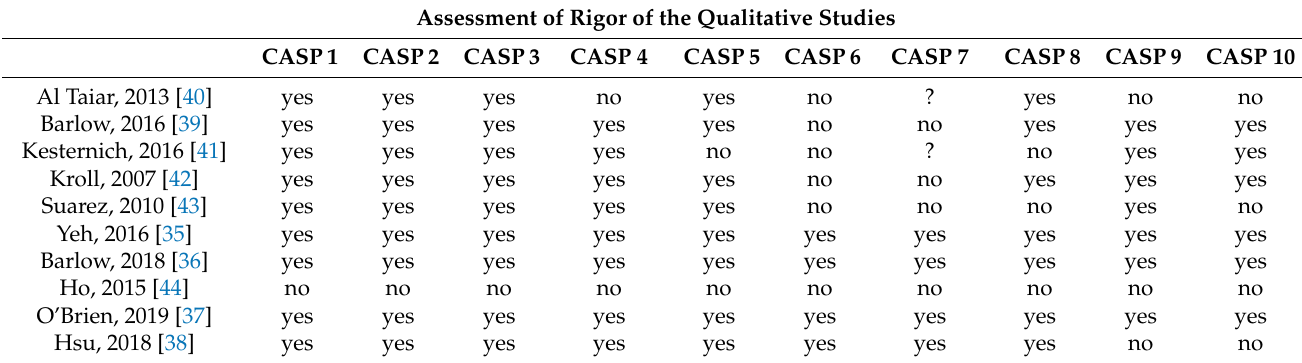
Table A3. Assessment of rigor of the qualitative